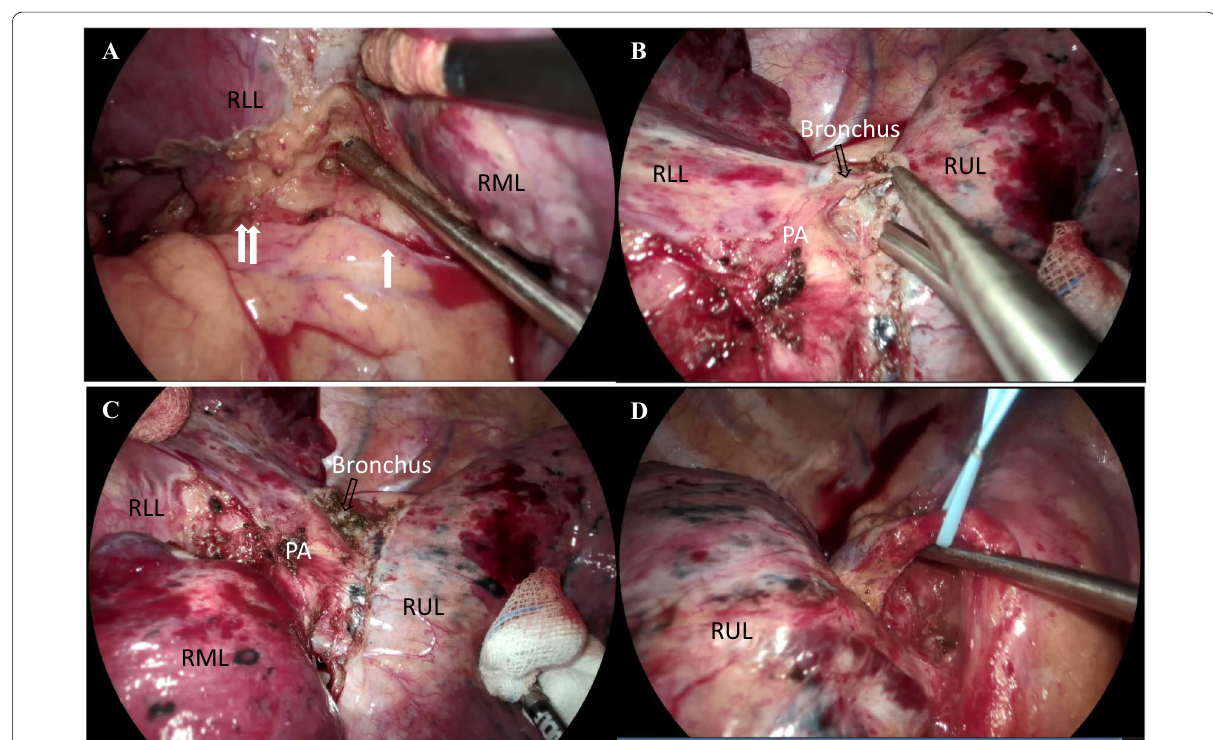
Fig. 5 Intraoperative photographs: a RML PV (white arrow) and IPV (double white arrow); b , c dense plane between interlobar PA and RIMB (prior to simultaneous stapling); d No. 2 and No. 4 lymph node